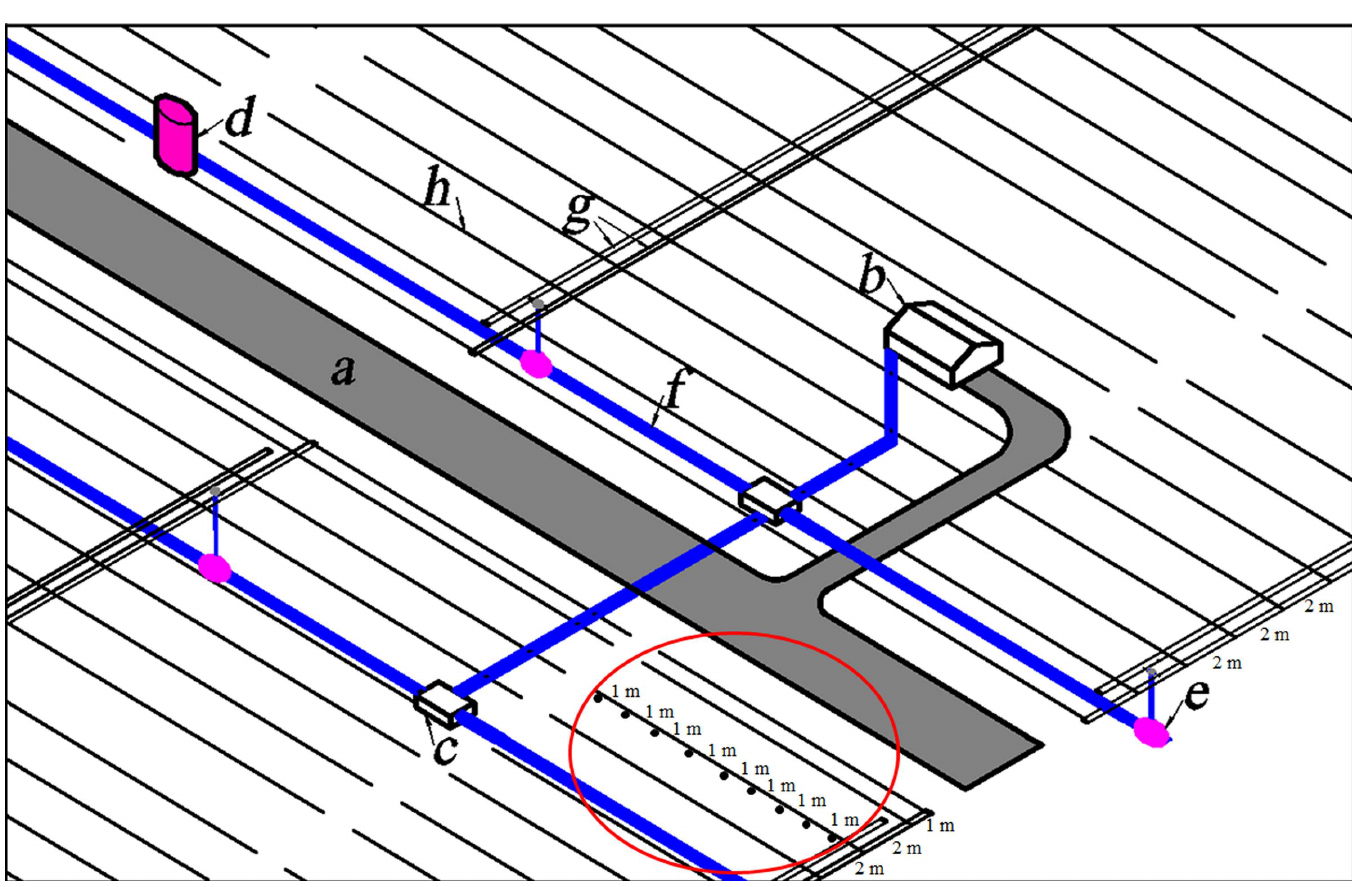
Fig 2. Schematic diagram of the drip irrigation system for the Taklimakan Desert Highway Shelterbelt. (a) Desert highway; (b) Well-house; (c) Control valve well; (d) Connecting well; (e) Water valve; (f) Main pipe; (g) Double-branch pipe; (h) Capillarytube. The spacing between capillary tubes is 2 m or 1 m. The spacing of the two adjacent emitters along the same capillarytube (black dots shown in the red circle) is 1 m, and all the capillary tubes are the same